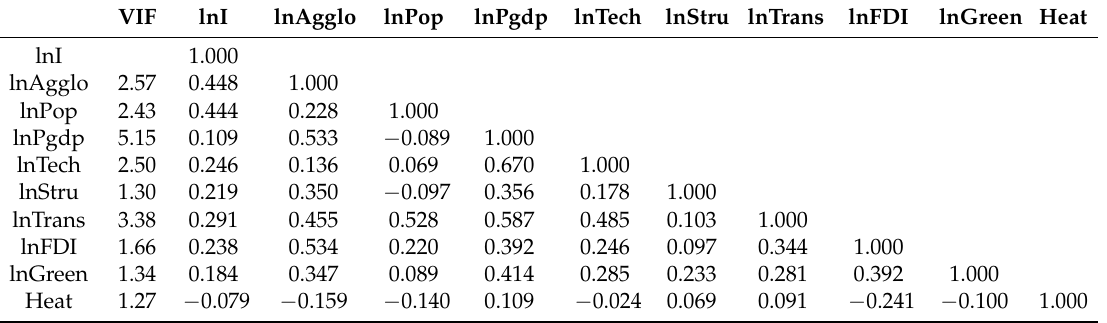
Table 2. Correlation Analysis and VIF